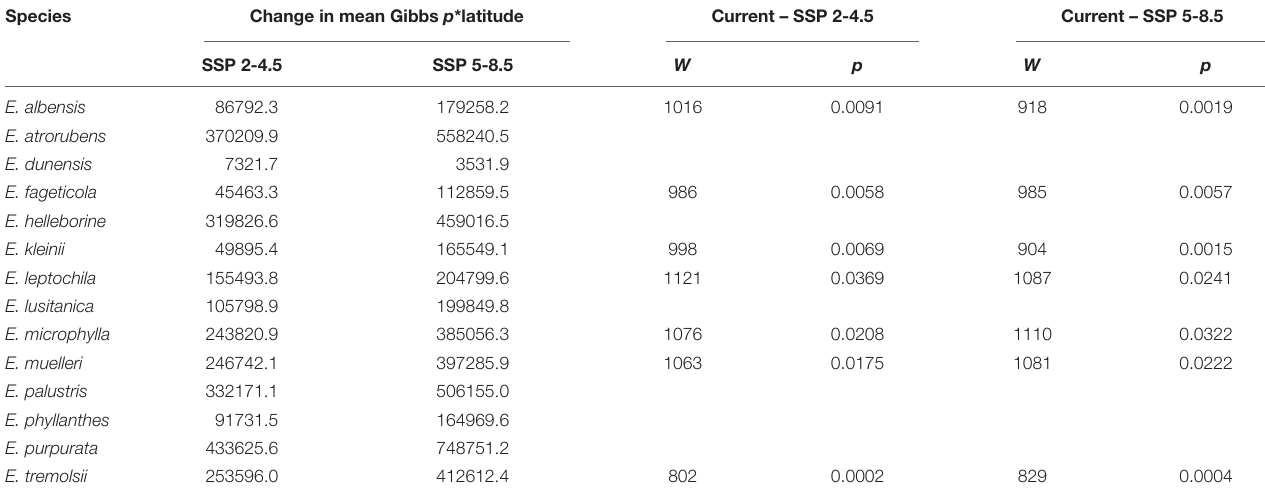
TABLE 2 | Latitudinal shifts in habitat distribution from current to future climate scenarios and results of Wilcoxon tests of differences in habitat distributions (showing only results for significant differences). Species Change in mean Gibbs p